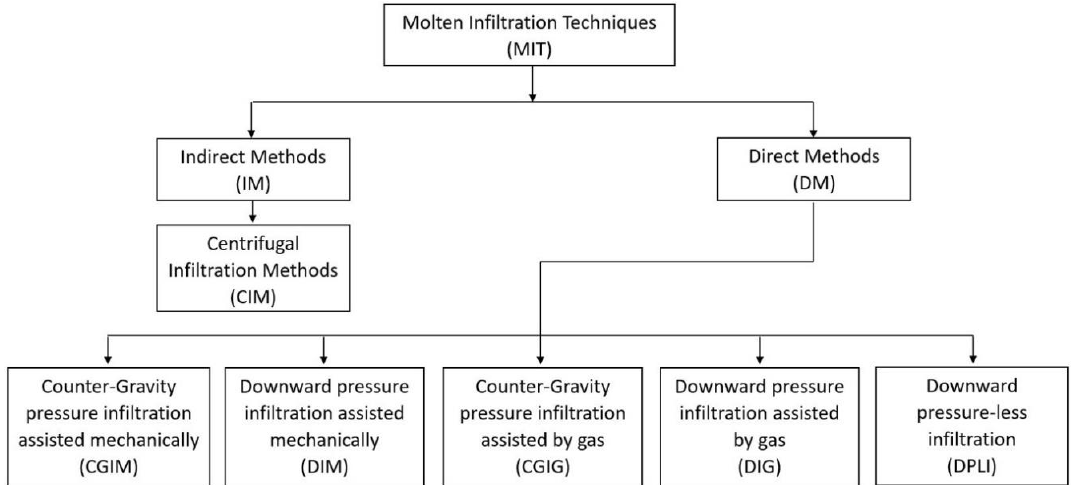
Figure 1. Classification of molten infiltration process for the fabrication of metal matrix syntactic foams (MMSF) adapted from [61].